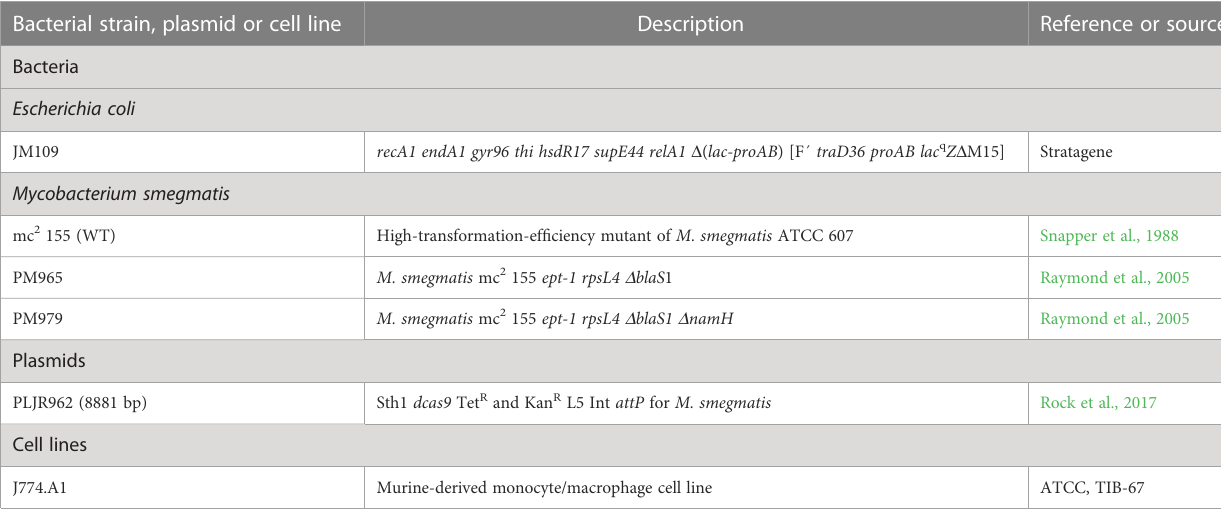
TABLE 1 Bacterial strains, plasmids and cell lines used in this study. Bacterial strain, plasmid or cell